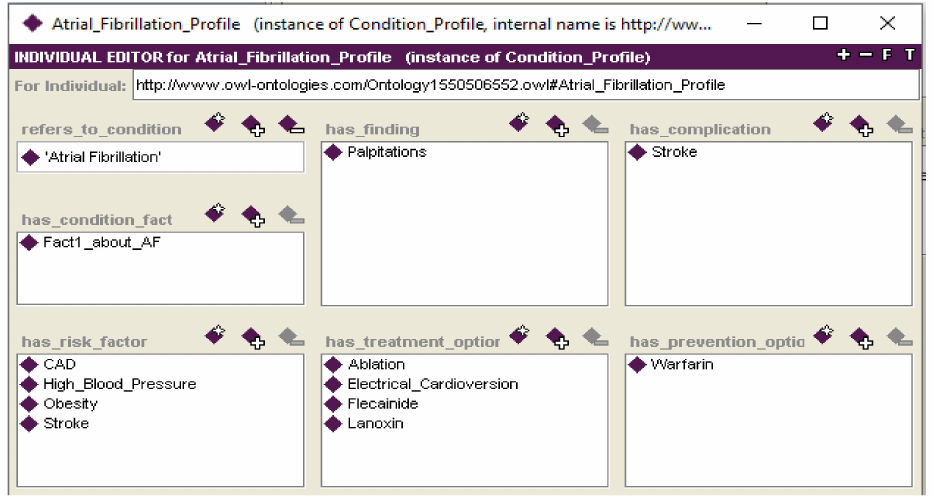
Figure 2. Condition_Profile concept for Atrial